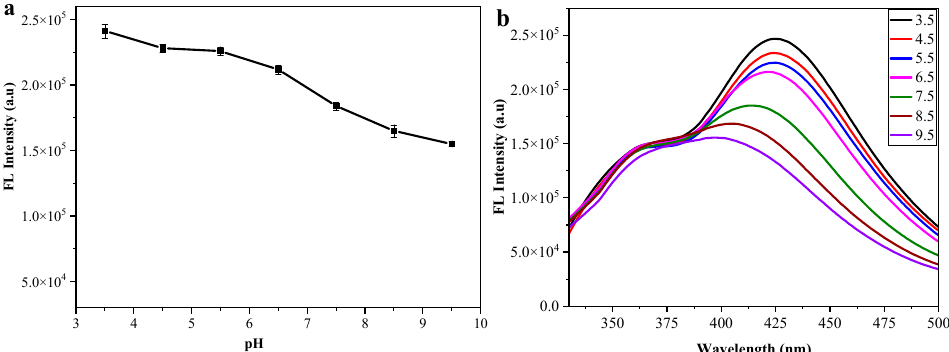
Figure 4. Influence of pH on the fluorescence intensity (a) and fluorescence emission spectrum (b) of poly(VPBA ‐ AAm) ‐ CD.